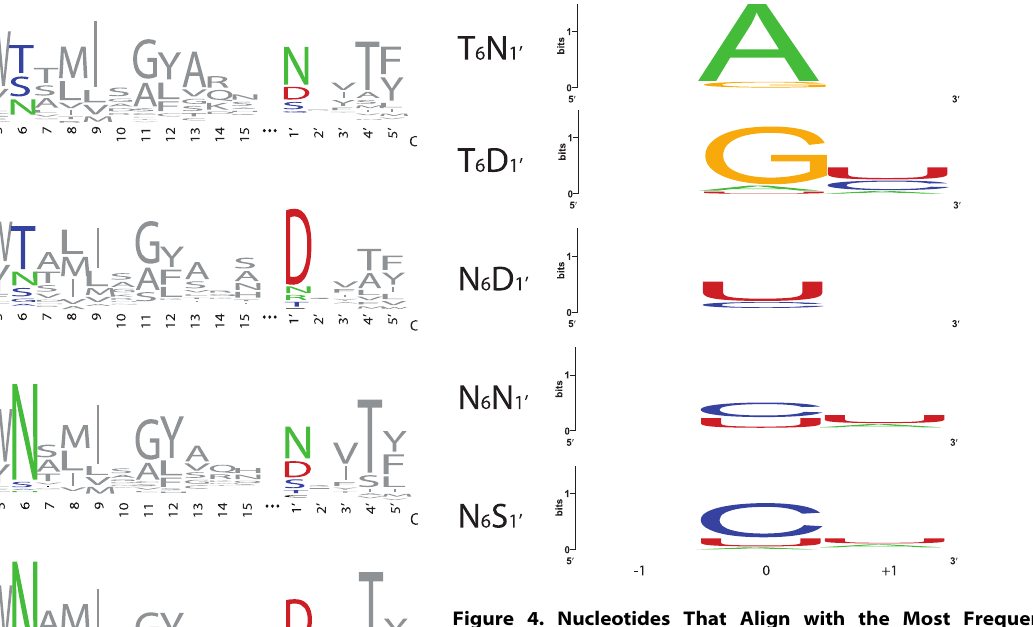
and A, respectively.